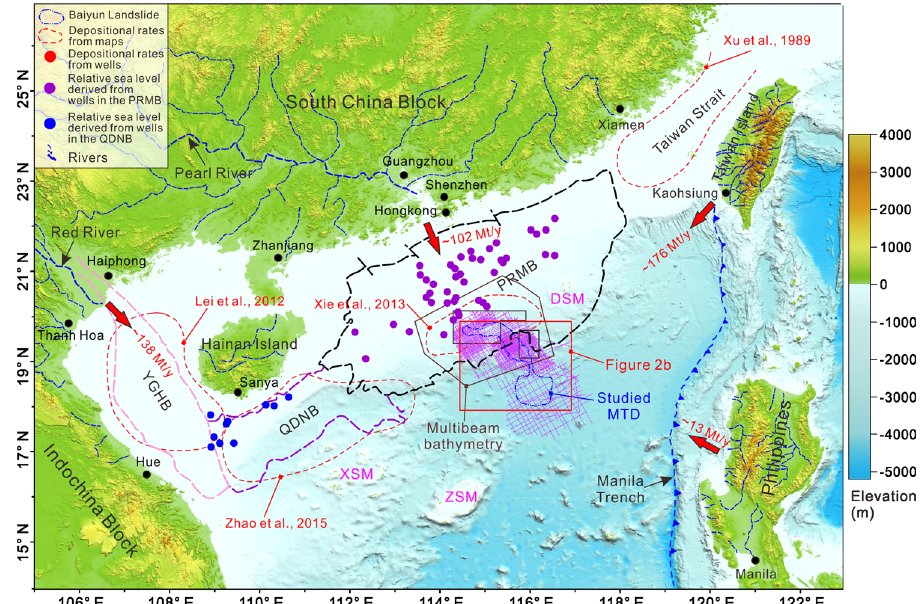
Fig. 1 Geological setting of the study area. Major basins such as the Pearl River Mouth Basin (PRMB, shown with a black dashed line), Qiongdongnan Basin (QDNB, shown with a purple dashed line), Yinggehai Basin (YGHB, shown with a light pink dashed line) are marked in the fi gure. The studied submarine landslide is delimited by a blue dashed line. Pink dashed lines and black squares highlight the 2D and 3D seismic data used in this study. The brown solid polygon refers to the multibeam bathymetric data. Sedimentation rates calculated from thickness maps in refs. 38,58,67,68 are shown by red dashed lines. Other well locations used to calculate sedimentation rates are shown in Supplementary Table S1. Exploration wells are used to restore relative sea-level changes in the Pearl River Mouth Basin (see purple circles) 55 , and in the Qiongdongnan and Yinggehai basins (see blue circles) 53 . Values of river discharge (see red arrows with black boundaries) are based on ref. 76 . Manila Trench is modi fi ed from ref. 45 . DSM Dongsha Massif, XSM Xisha Massif, ZSM Zhongsha